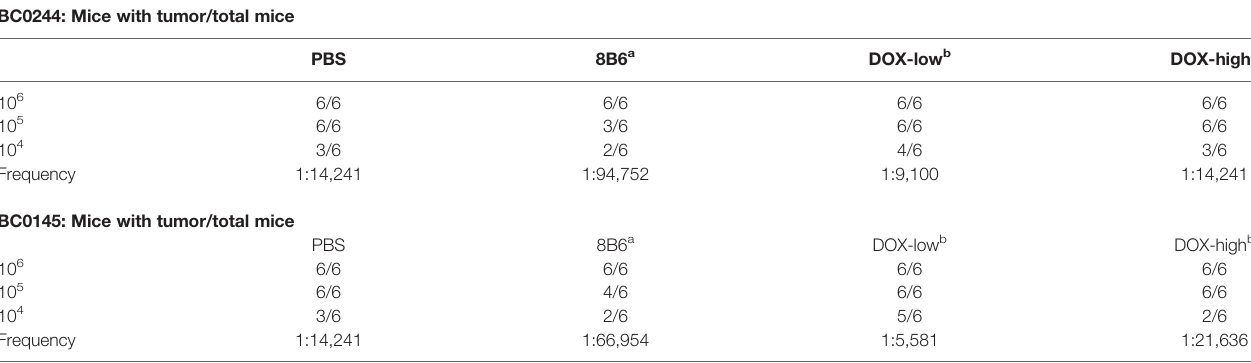
TABLE 3 | Estimated frequencies of tumor-initiating cells in PDXs of breast cancer treated with Doxorubicin or mAb8B6. BC0244: Mice with tumor/total